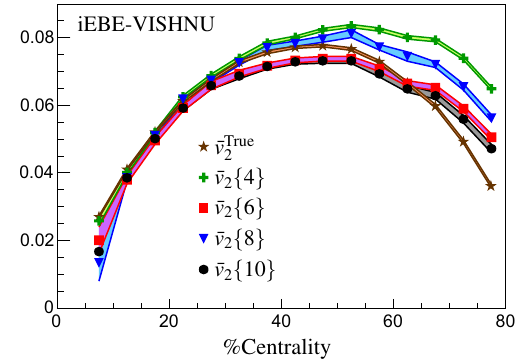
In order to improve the estimation of ¯ v 2 , we set q 2 { 6 } = 0 in Eq. (36c). This equation has six roots, where only two of them are real and positive. In addition, as can be seen from Fig. 4, the true value of ¯ v 2 is always smaller than v 2 { 4 } ( = ¯ v 2 { 4 } ) in higher centralities. In fact, it is true for all v 2 { 2 k